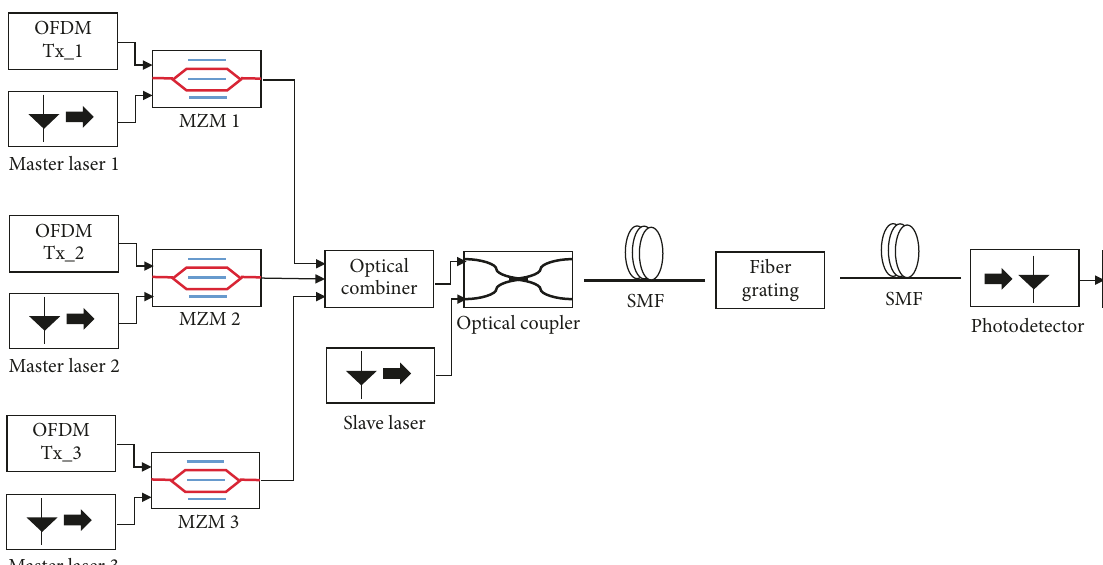
Figure 2: Configuration of 3-channel OFDM-WDM system using master-to-slave injection-locking technique.